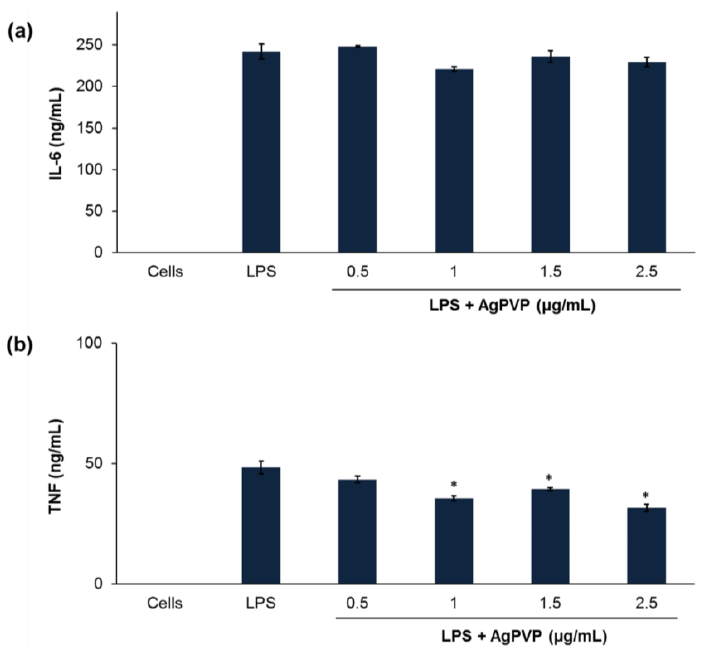
Figure 6. The effect of non-conjugated Ag-PVPs on the production of IL-6 ( a ) and tumor necrosis factor (TNF) ( b ) by mouse J774 macrophages stimulated with LPS after 72 h. Cells (10 6 cells/mL) were stimulated with LPS (1 μg/mL) and treated with different concentrations of Ag-PVPs (stored one week at 4 °C). Cell-free culture supernatants were collected at 72 h post-incubation and used to measure the production of IL-6 by cytokine ELISA. Untreated and LPS-stimulated cells were used as positive controls, and untreated and non-stimulated cells were used as negative controls. * indicates a significant difference ( p < 0.01) between the untreated and LPS-stimulated cells versus LPS-stimulated and treated cells as calculated by the unpaired Student’s t -test. The data are presented as means and standard deviations of samples run in triplicate and are representative of three separate